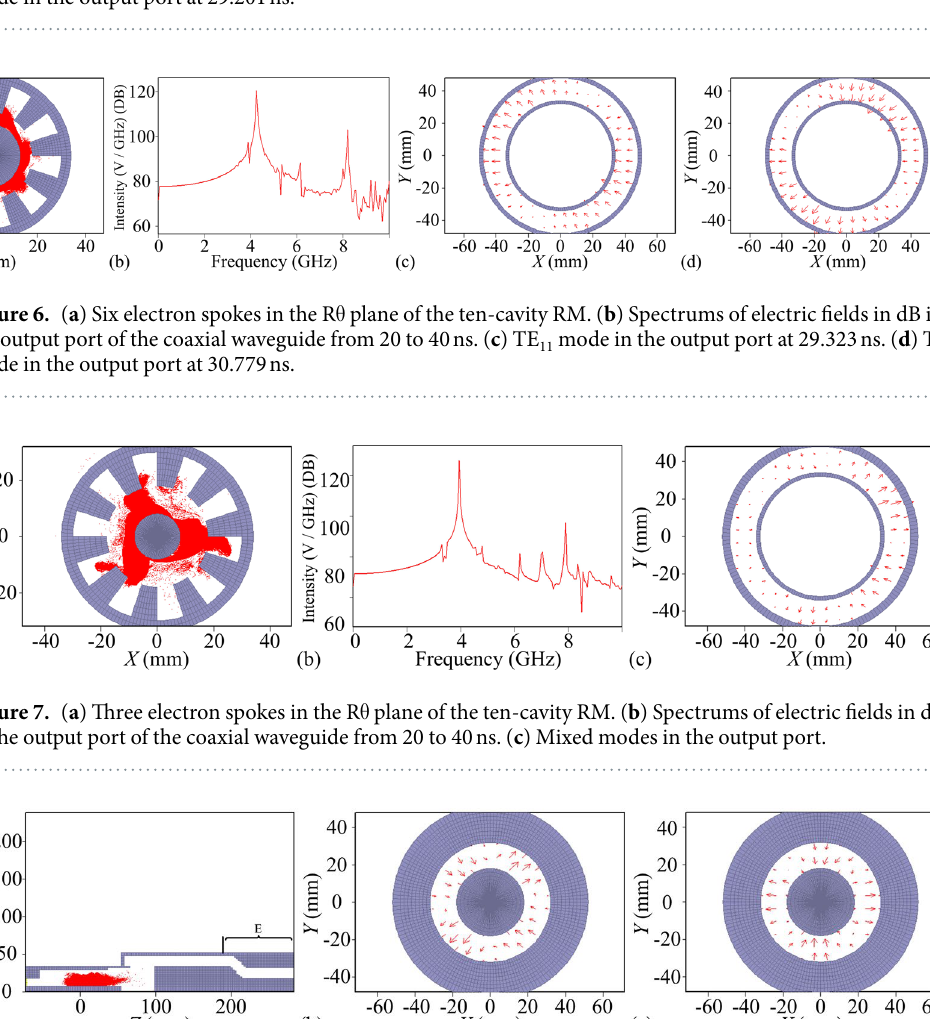
Figure 5. ( a ) Four electron spokes in the R θ plane of the ten-cavity RM. ( b ) Spectrums of electric fields in dB in the output port of the coaxial waveguide from 20 to 40 ns. ( c ) TE 11 mode in the output port at 27.949 ns. ( d ) TE 11 mode in the output port at 29.201 ns.